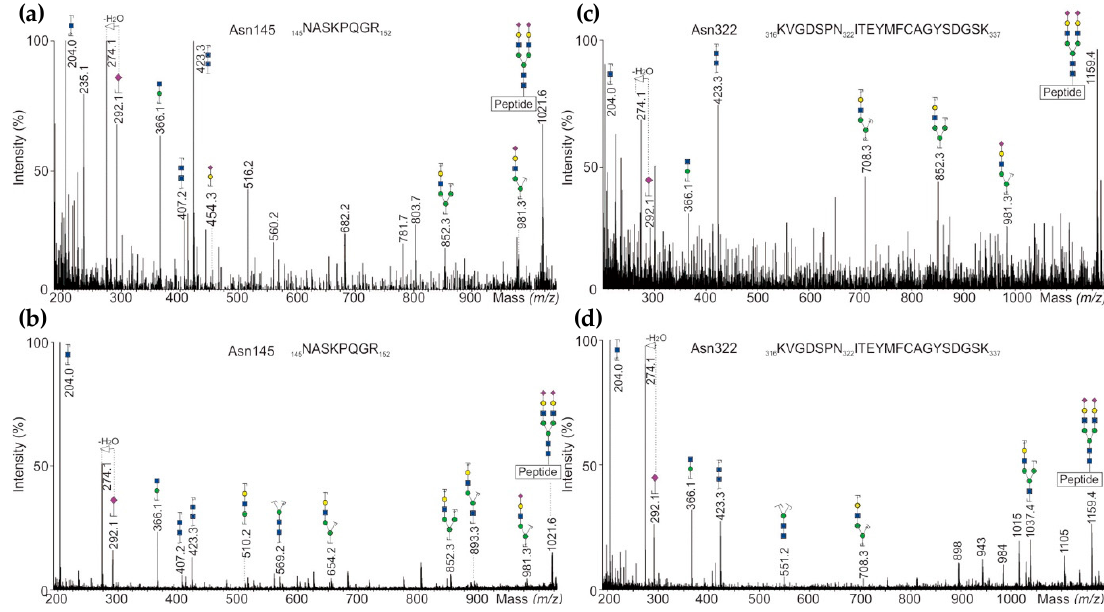
Figure 3. ( a ) UHPLC-QTOF-MS/MS E spectra of N-glycopeptides representing N-glycosylation site Asn145 detected in NovoSeven ® , and ( b ) in AryoSeven™; ( c ) site Asn322 in NovoSeven ® , and ( d ) in AryoSeven™.